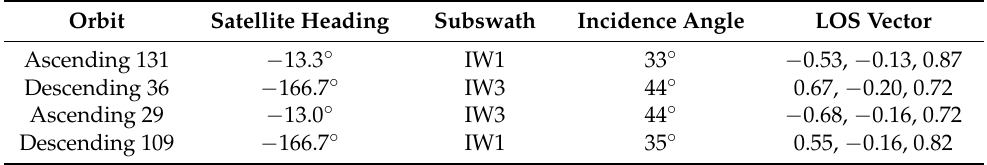
Table 3. Incidence angles for the Gulpinar area as computed from S1 orbital information. Heading is angle counterclockwise from North, subswath indicates the part of the S1 frame that was processed (frames are shown in Figure 1). LOS vector it is in unit of 1, east, north, Up components, respectively. Orbit